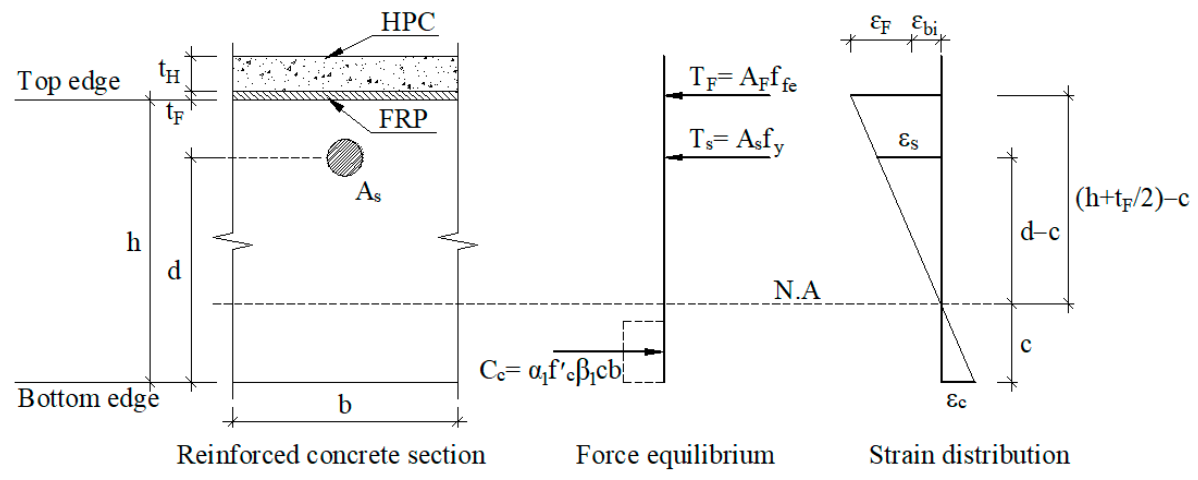
Figure 5. Retrofitting mechanism for negative moment sections (refer to section “N-N” of Figure 1). For the positive moment sections, the HPC overlay on the top of the slab as section M-M of Figure 1 must have enough thickness and compressive strength to pull the neutral axis towards the overlay zone leading to FRP in tension at failure. The rationale for the retrofitting mechanism is similar to that for negative moment sections, as shown in Figure 6.